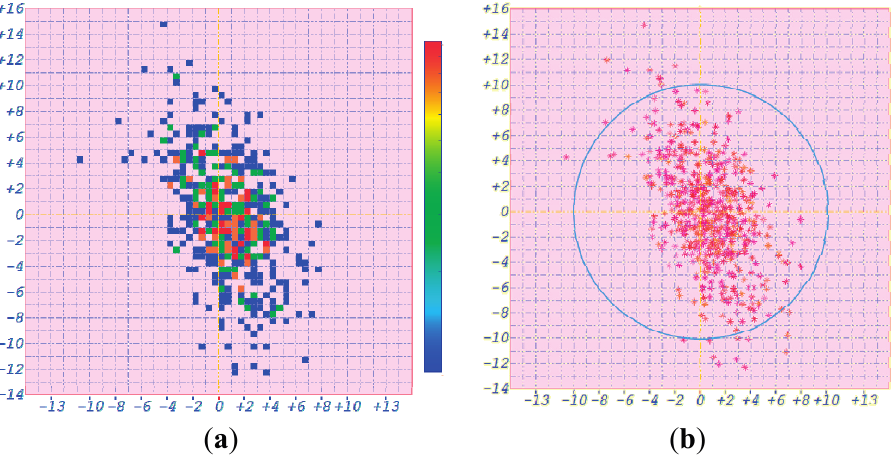
Figure 18. Positioning errors for the dynamic position ( a ) Thermography diagram; ( b ) Scatter diagram